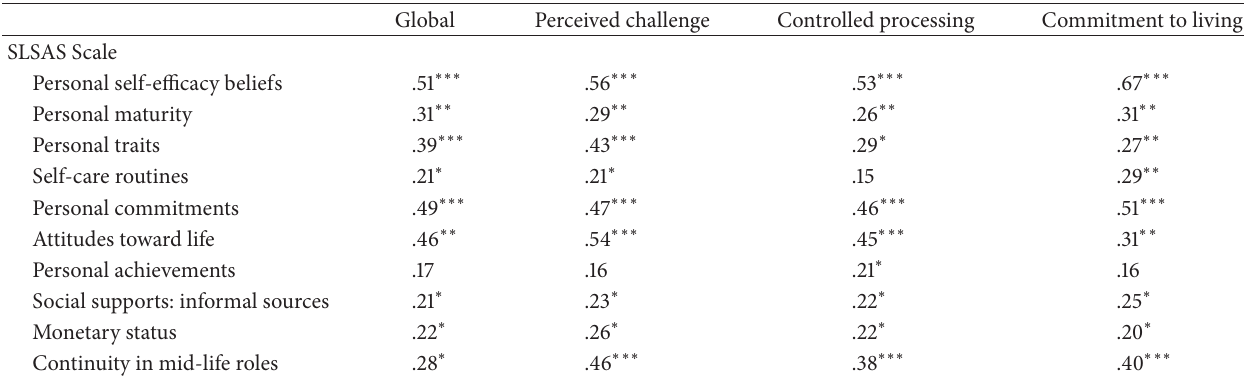
Table 4: Correlation coefficients of SLSAM scales with outcome measures of global resilience and its four subscales of perceived challenge, controlled processing, commitment to living (DRS: dispositional resilience scale, Bartone et al., 1989 [15]) administered at 24-month followup from date of baseline assessments of the SLSAS measure (sample = 150).